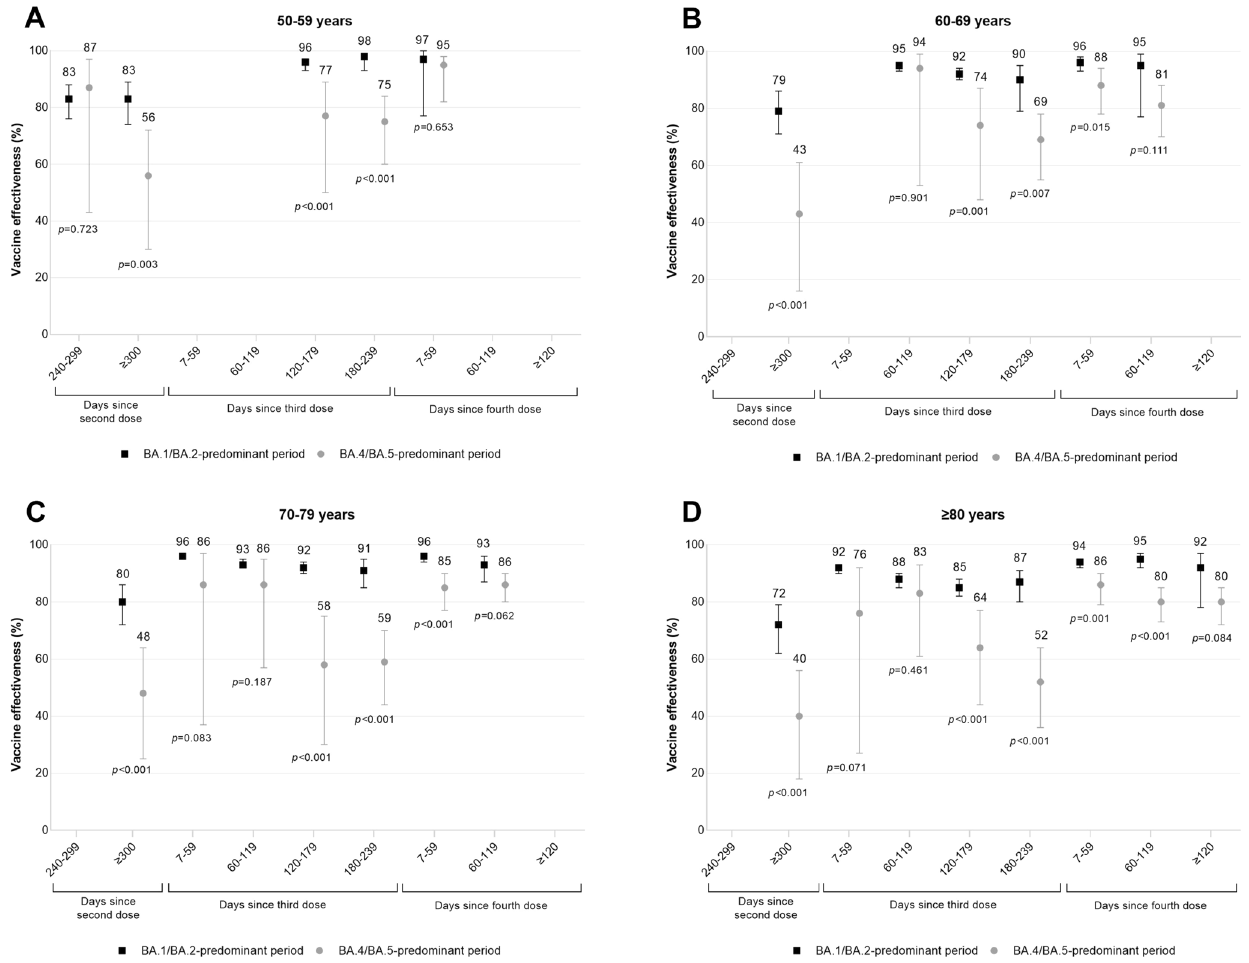
Fig. 3 | Vaccine effectiveness and 95% con fi dence intervals, during periods of BA.1/BA.2 (January 2 to July 2, 2022) and BA.4/BA.5 (July 3 to October 1, 2022) predominance, by time since vaccination. Vaccine effectiveness (presented as proportions out of 100 percentage points) and 95% con fi dence intervals against Omicron-associated severe outcomes among community-dwelling adults aged ( A ) 50 – 59 years, ( B ) 60 – 69 years, ( C ) 70 – 79 years, and ( D ) ≥ 80 years in Ontario,